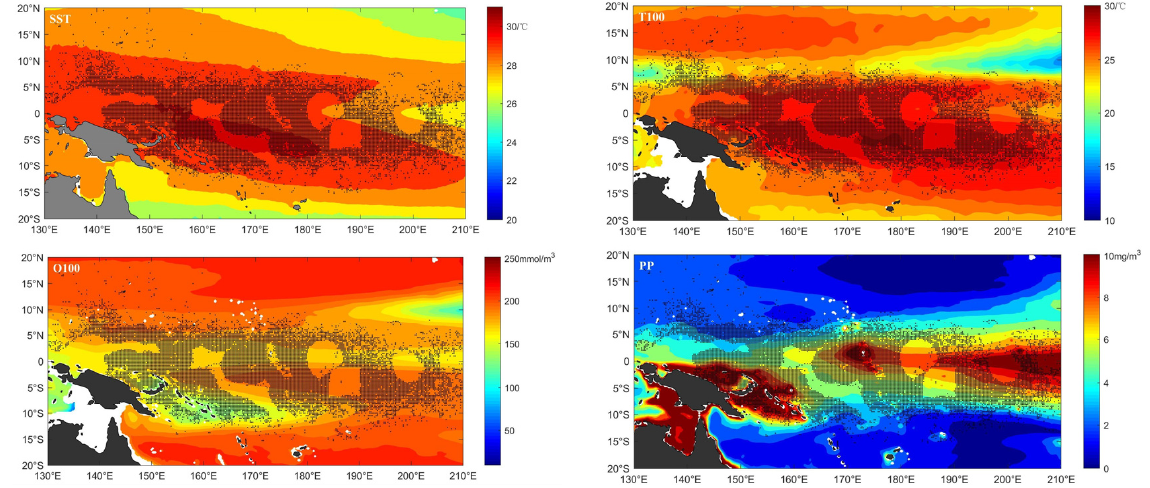
Figure 2. The spatial distribution of high FE (greater than the mean value) locations overlayed with important factors at the 0.25 spatial scale during 2015 to 2019.